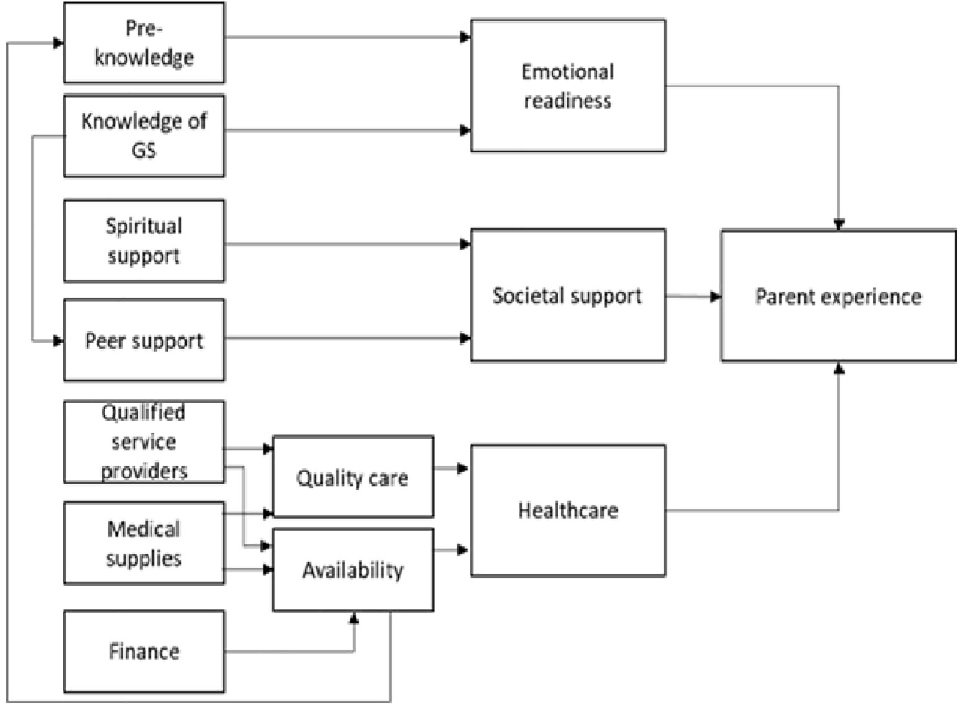
Fig 1. Logic model of the